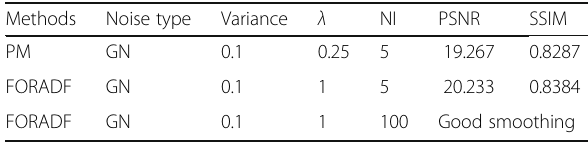
Table 1 Performance for Gaussian noise